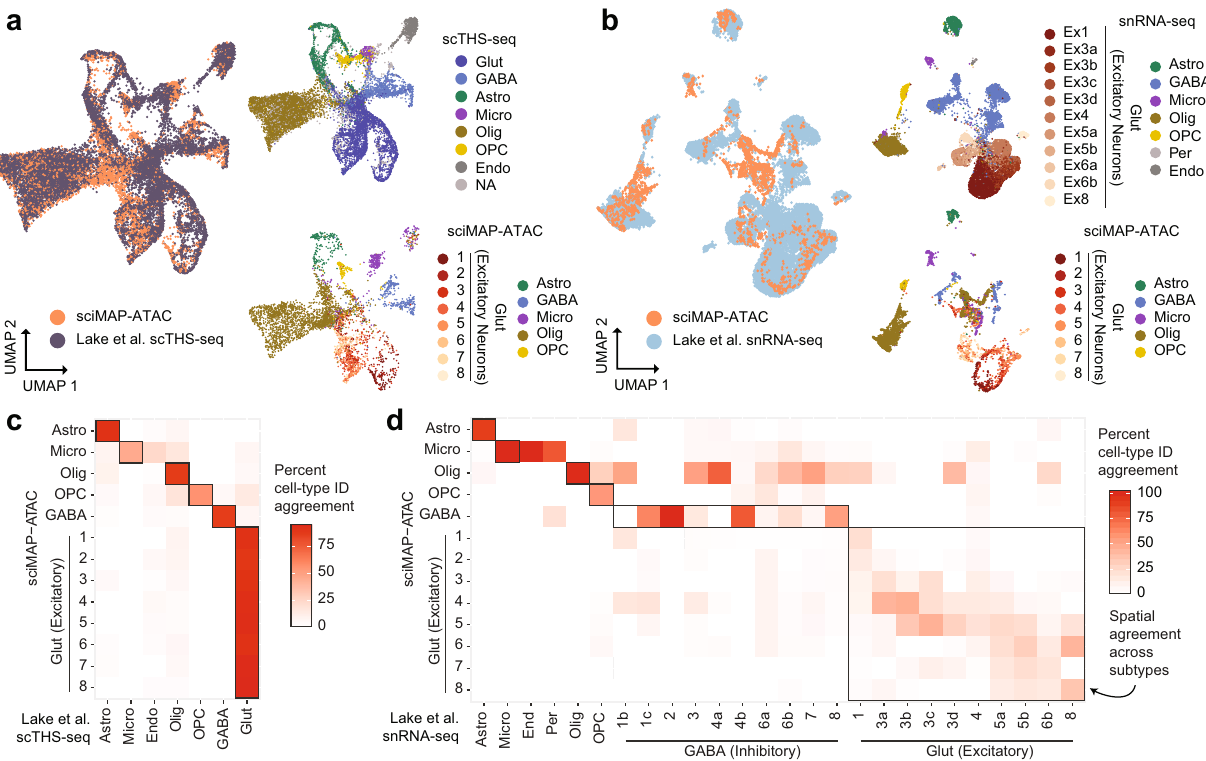
Fig. 5 Integration of sciMAP-ATAC with snRNA-seq and scTHS-seq human VISp datasets. a Co-embedding of sciMAP-ATAC and scTHS-seq cell pro fi les from Lake et al. 29 using Signac 75 in a joint UMAP. Top right shows only scTHS-seq cells colored by cell type identi fi ed in Lake et al. 29 and bottom shows sciMAP-ATAC cells colored by our called cell types as in Fig. 4c, except for glutamatergic neurons which are colored by spatial positions 1 – 8 (Glut glutamatergic (excitatory) neurons, GABA GABAergic (inhibitory) neurons, Astro astrocytes, Micro microglia, Olig oligodendrocytes, OPC oligodendrocyte precursor cells, Endo endothelial cells, NA not applicable — no cell type provided). b Co-embedding of sciMAP-ATAC and snRNA-seq transcriptional pro fi les from Lake et al. 29 using Signac. Top right shows only snRNA-seq cells. Abbreviations as in a , but with the addition of Per = pericytes, and glutamatergic (excitatory) neurons (Ex) are colored by subtype identi fi ed in Lake et al. 29 . Bottom right shows only sciMAP-ATAC cells, with glutamatergic neurons colored by spatial position 1 – 8. c Confusion matrix representing the percent agreement in predicting the cell type of a cell from one dataset using the other between sciMAP-ATAC and scTHS-seq cells. d As in c , but between sciMAP-ATAC and snRNA-seq. Spatial agreement between excitatory neuron subtypes identi fi ed in the snRNA-seq data correspond to the spatial positioning of cells within our sciMAP-ATAC dataset. Source data are provided as a Source data fi